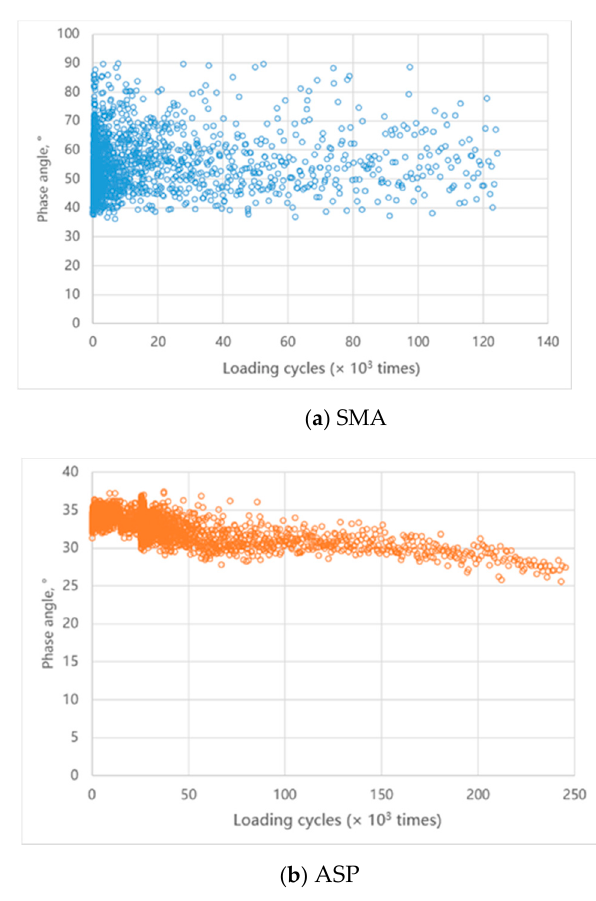
Figure 16. Phase angles of specimens during loading.